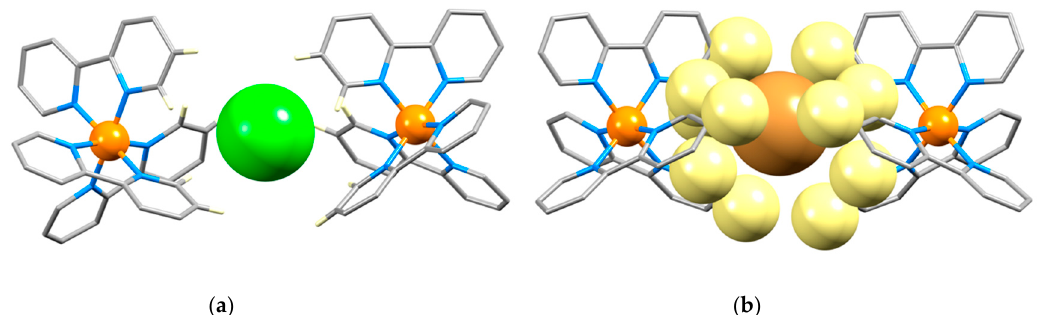
Figure 5. ( a ) The Structure Type 2 has three bpy ligands of each of the two [M(bpy) 3 ] n + cations interacting with halide ions located between the sheets of cations, resulting in a set of six H-6 and six H-5 interactions as seen in [Os(bpy) 3 ] 2 [Cr(CN) 6 ]Cl·8H 2 O (Refcode HIRDOB) [81]. The halide ion is shown in a space-filling mode, and the metal atoms in ball and stick representations. ( b ) The 12 C–H bonds provide a cavity for the halide guest, as seen in [Ru(bpy) 3 ] 2 [Cr(CN) 6 ]Br·8H 2 O (Refcode HIRDUH01) [109]. The Structure Type 2 halide ion and the interacting hydrogens are shown in a space-filling mode, and the metal atoms in ball and stick representations.